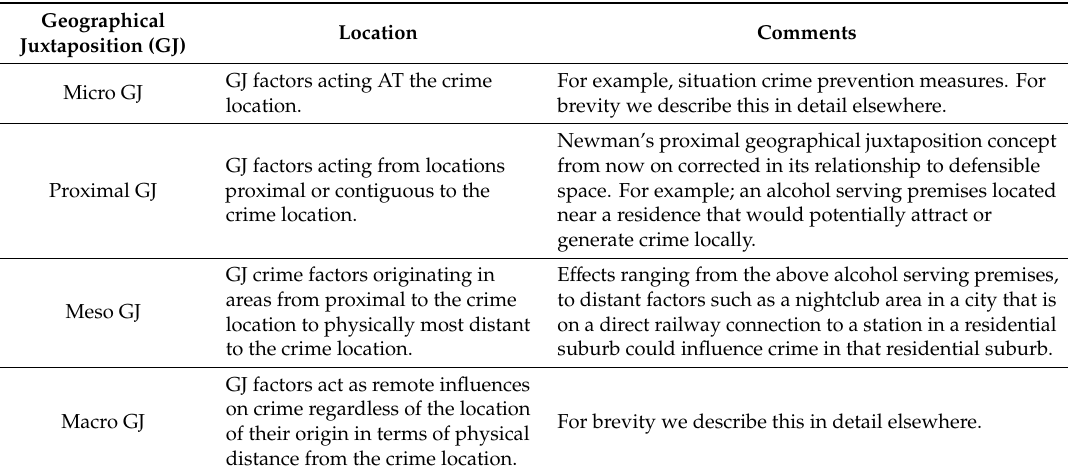
Table 1. Four Categories of Geographical Juxtaposition.